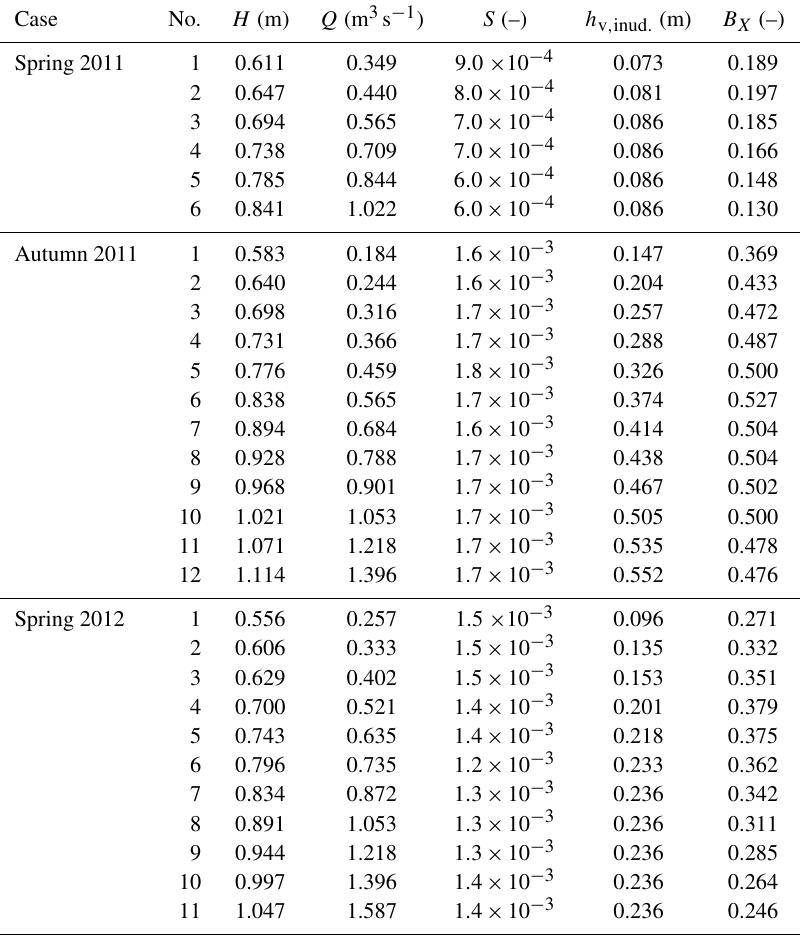
Table A3. Data for the Ritobacken case study used in calculations: water depth H , flow rate Q , energy grade slope S , inundated vegetation height h v , inud . , and blockage factor B X . Water depths H were obtained by averaging upstream and downstream depths. Original data collected by Västilä et al.